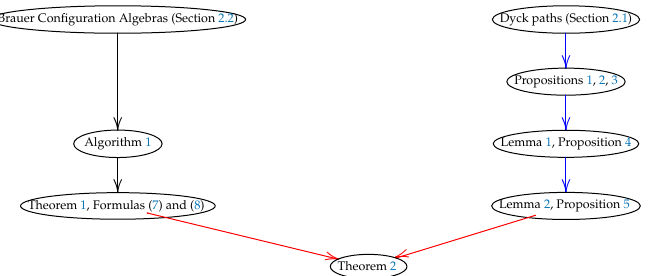
Figure 1. Main results presented in this paper (targets of blue and red arrows) allow establishing a connection between Brauer configuration algebras and Dyck paths theories. Propositions 1–3 give properties of a suitable integer sequence related to the Catalan triangle entries via Lemma 1 and Proposition 4. We introduce a Brauer configuration Γ x , whose vertices occur in polygons according to entries of suitable matrices whose properties are given in Lemma 2. Proposition 5 proves that the Catalan triangle gives entries of such matrices. Theorem 2 gives a formula for the dimension of a Brauer configuration algebra (and its corresponding center) defined by Dyck